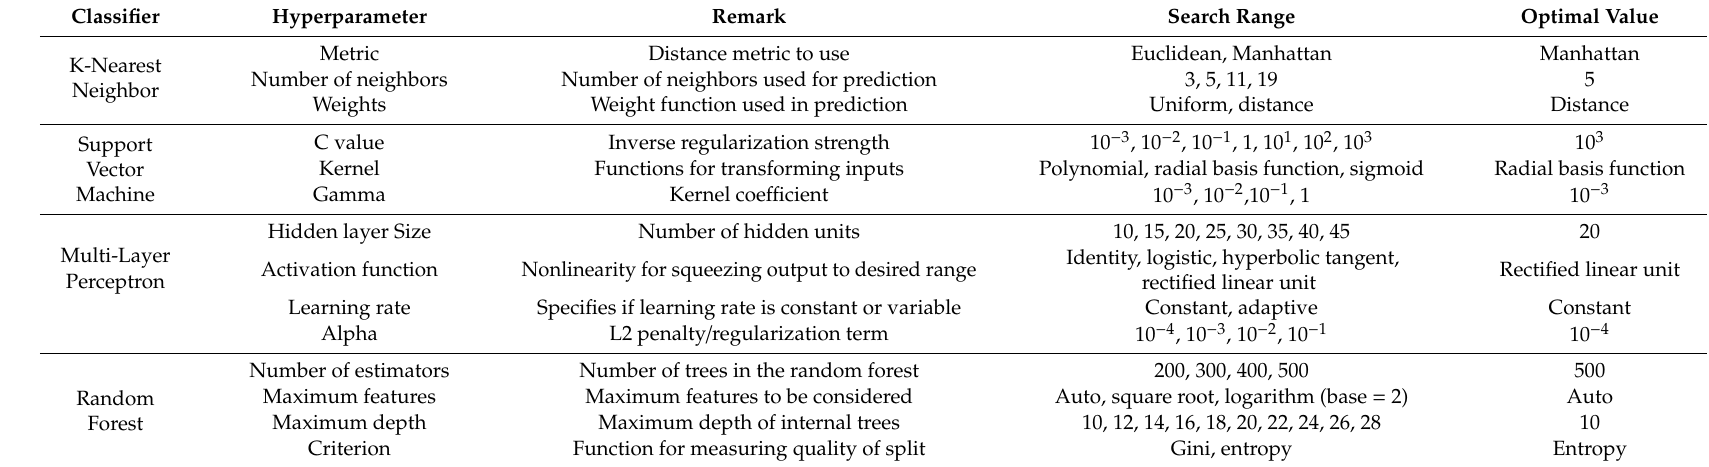
Table 2. Hyperparameters, search range, and optimal values of the machine learning-based landslide susceptibility